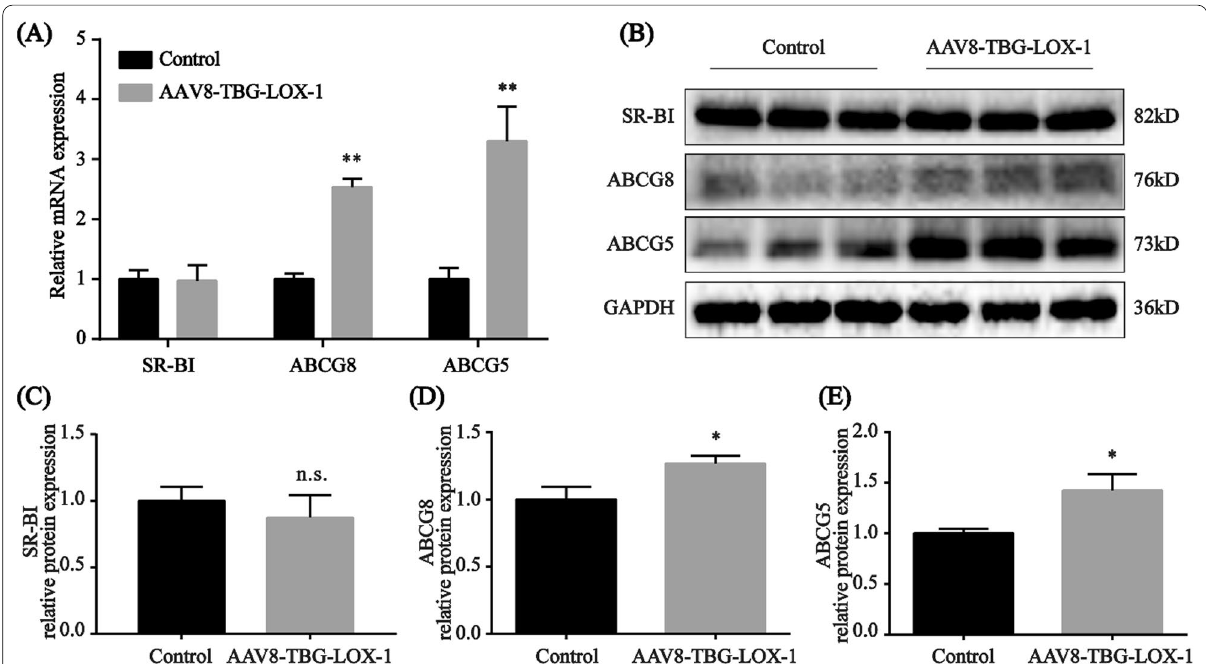
Fig. 7 Quantitative real-time PCR and Western blot analysis of SR-BI, ABCG5, and ABCG8. A Quantitative real-time PCR analysis of the mRNA levels of SR-BI, ABCG8 and ABCG5 in liver of the mice in the control and LOX-1 groups. The expression of mRNA was normalized to that of GAPDH. B - E Western blot analysis of the hepatic lipid metabolism core pathway-related proteins SR-BI, ABCG5, and ABCG8 8 weeks after virus transduction. Values are expressed as mean SD. **P < 0.01 compared with the control ±